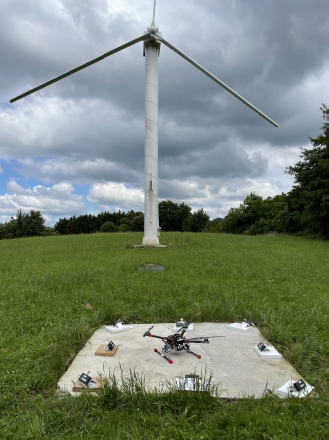
Figure 9. Set-up in the outdoor environment.